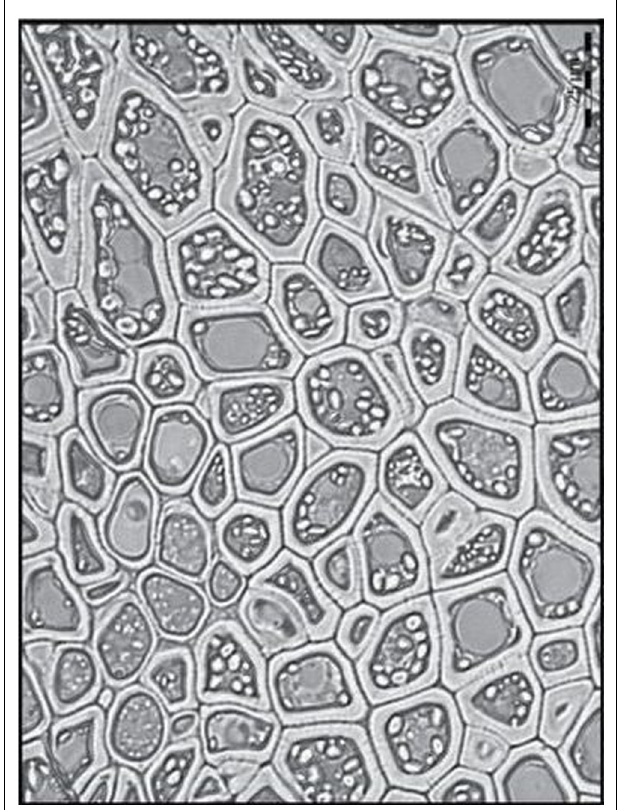
FIGURE 6 |Thick endosperm cell walls in Brachypodium distachyon grain. Reproduced with permission fromTrafford etal. (2013).